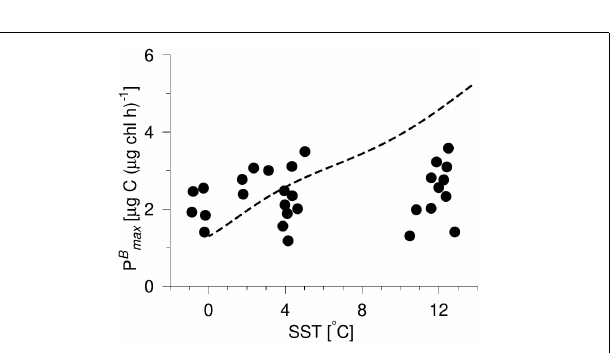
FIGURE 6 | Calculated P B max from incubation experiments versus SST (bullets, water samples are from the surface (5 m) and locations are shown in Figure 1 ), and the applied parameterization of P B max in the VPP and VGPM-models (dashed line).